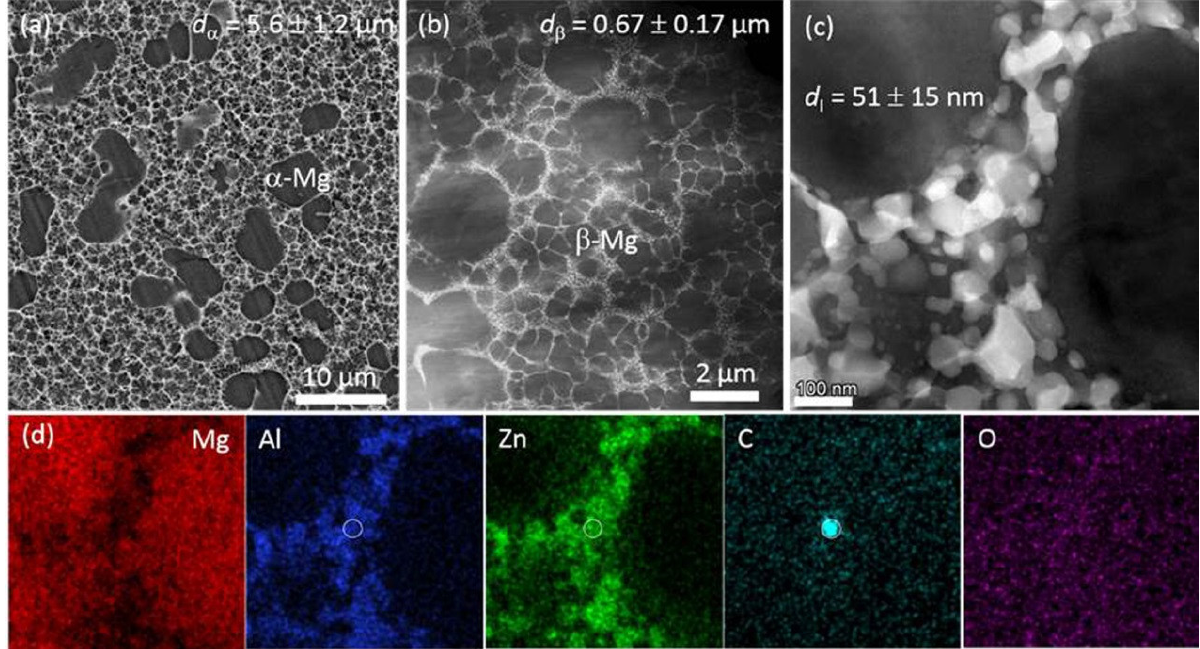
Figure 16. ( a ) SEM image; ( b , c ) HAADF-STEM images; ( d ) EDS mappings of the region shown in ( c ) in the HPDC ZA88 alloy [65].